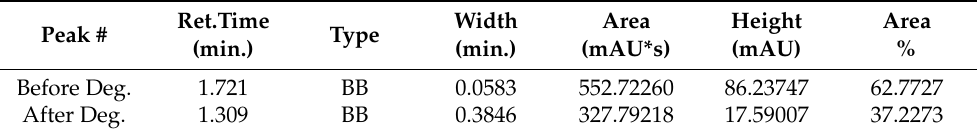
Table 5. Data analysis of the HPLC chromatogram for the imidacloprid solution treated with